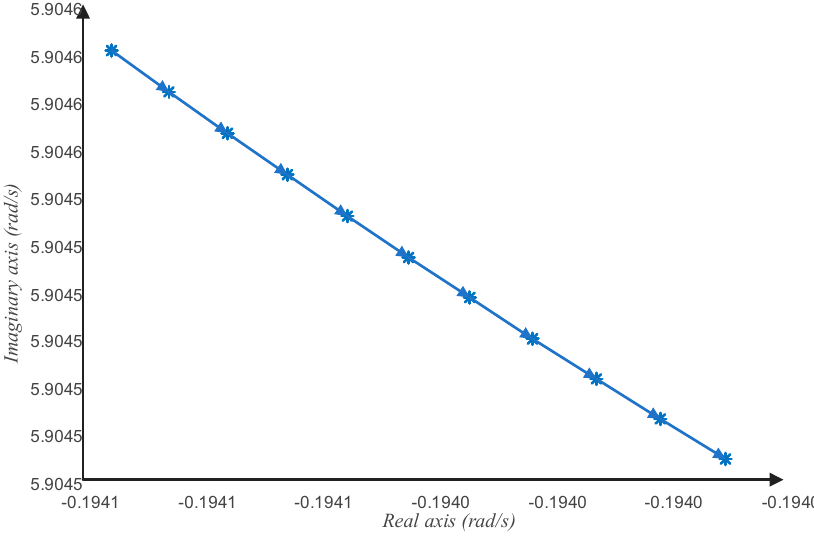
Figure 11. Modal trajectory regulated by the data-loss ratio (0 to 0.2).